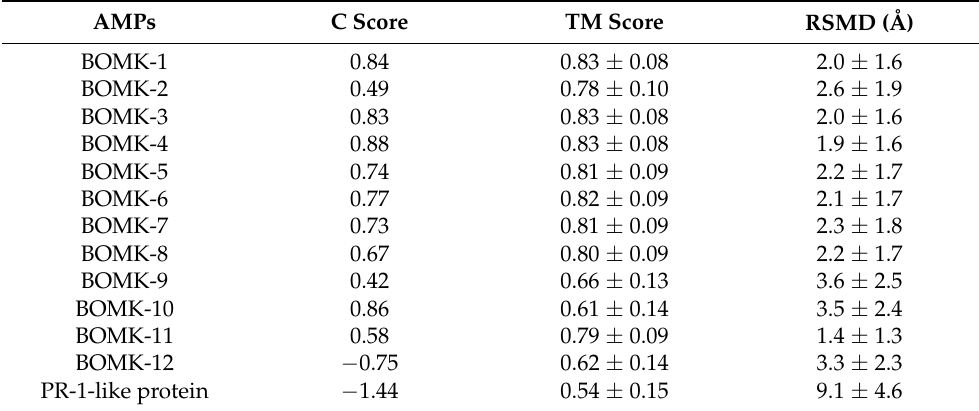
Table 6. Structure prediction of the anti- Fusarium oxysporum AMPs and PR-1-like protein, Fpr1, from